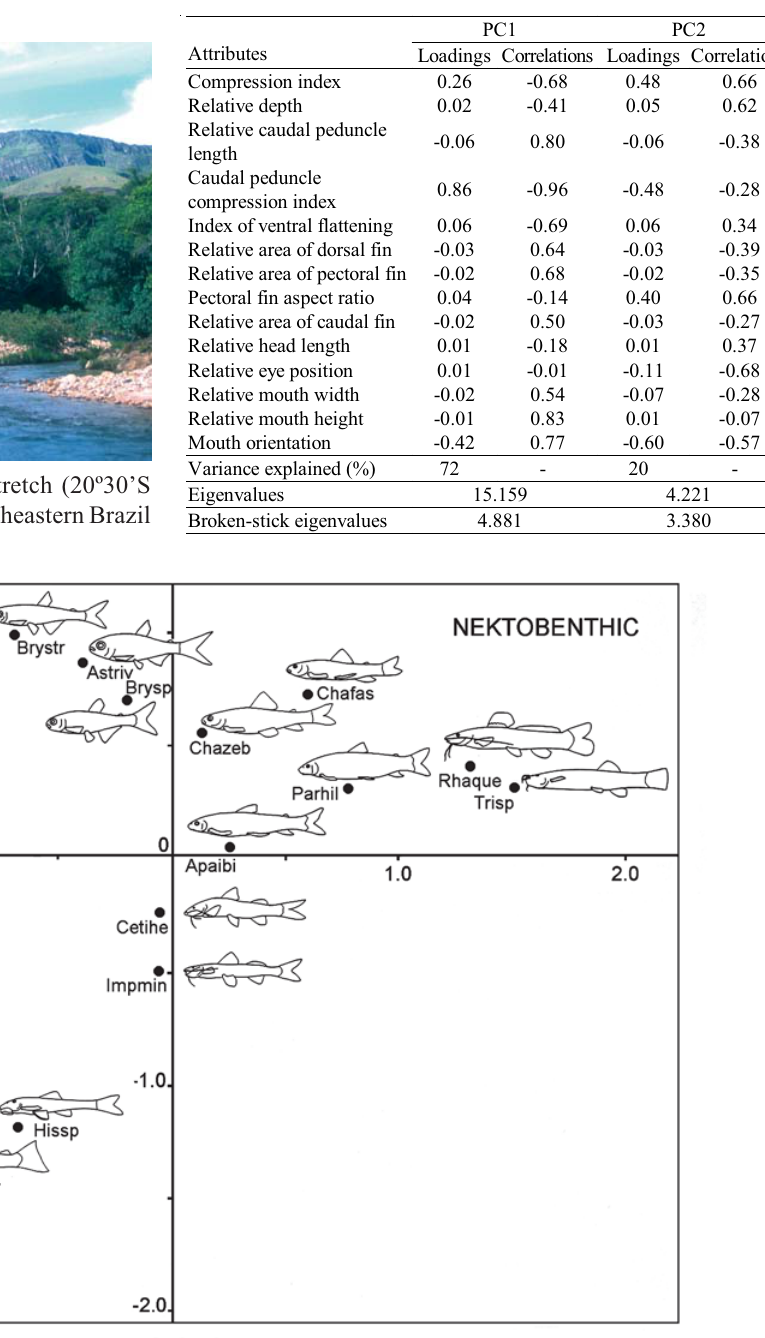
Table 3. Loading and correlation values of the 14 ecomorpho- logical attributes in the two axis, with the first axis representing the principal component 1 (PC1) and the second axis the princi- pal component 2 (PC2), calculated for the fish species resident in the studied upper rio São Francisco riffles, southeastern Brazil.